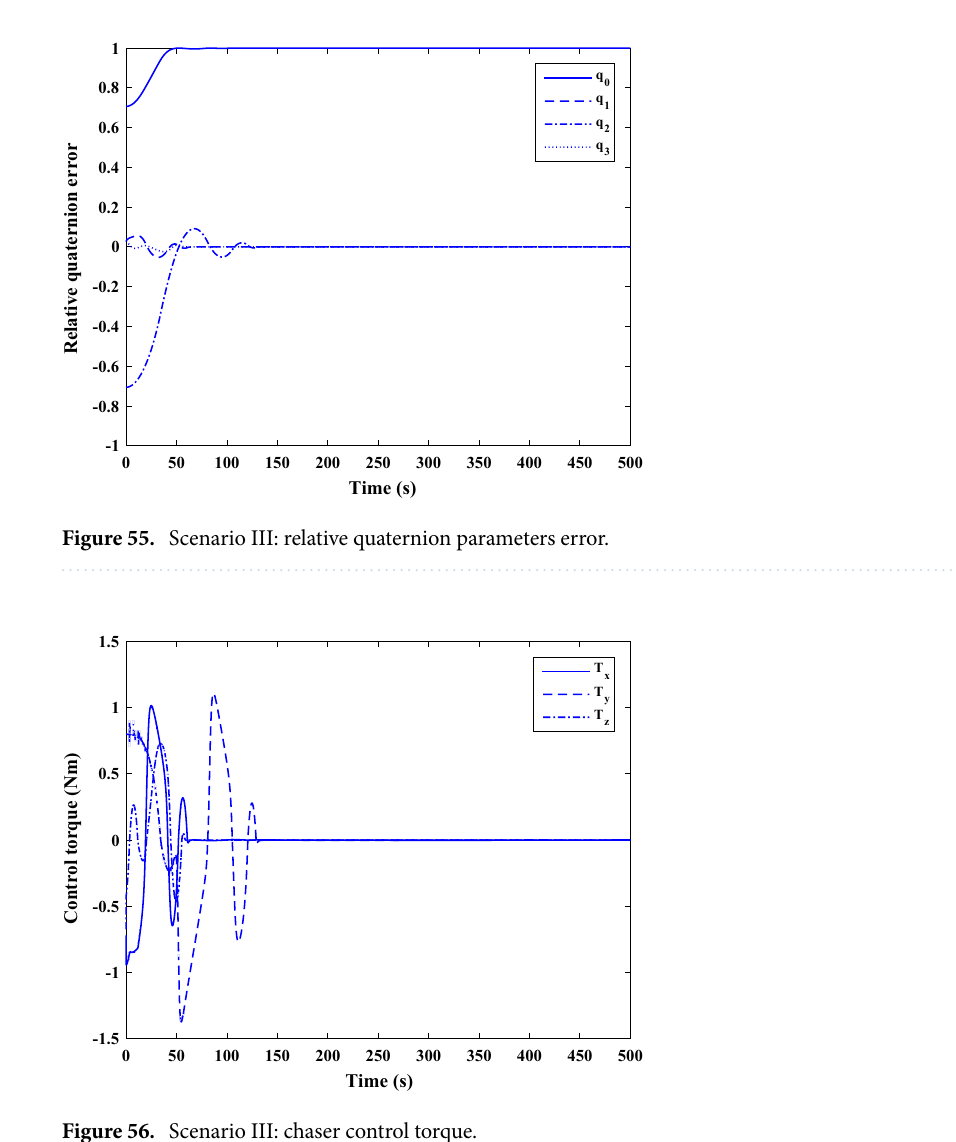
Figure 56. Scenario III: chaser control torque.